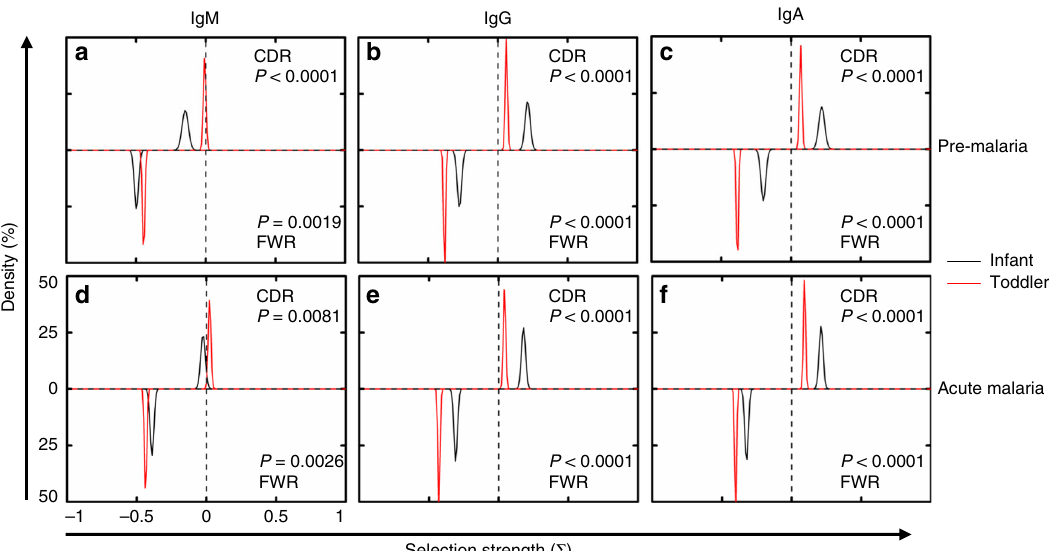
Fig. 4 Antigen selection strength comparisons between infants and toddlers. Selection strength distributions, as determined by BASELINe 37 , were compared between infants ( black ) and toddlers ( red ) for PBMCs from pre-malaria ( a – c ) ( N infant = 6, N toddler = 9) and acute malaria ( d – f ) ( N infant = 6, N toddler = 9) time points, separated by isotype: a , d IgM; b , e IgG; and c , f IgA. Selection strength on CDR (CDR1 and 2, top half of each panel ) and FWR (FWR2 and 3, bottom half of each panel ) for unique RNA molecules was calculated. CDR3 and FWR4 were omitted due to the dif fi culty in determining the germline sequence. FWR1 for all sequences was also omitted because it was not covered entirely by some of the primers. P value calculated as previously described